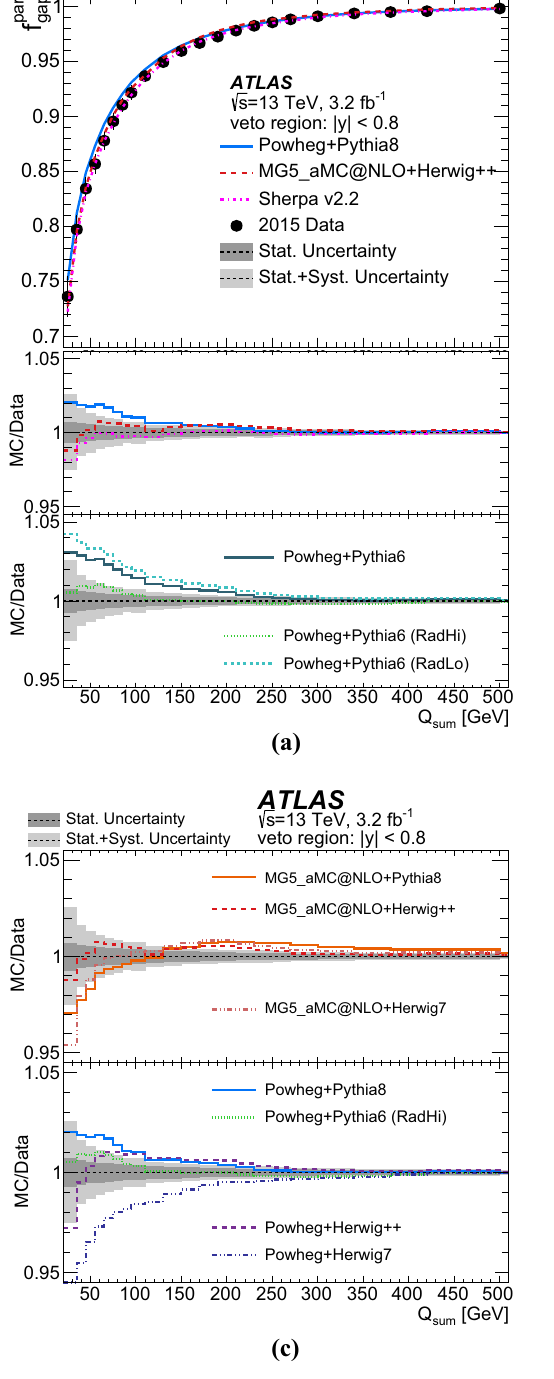
Fig. 11 The measured gap fraction f part gap ( Q sum ) as a function of Q sum in different rapidity veto regions, a | y | < 0 . 8 and b | y | < 2 . 1, followed by ratios of prediction to data of the measured gap fraction f part gap ( Q sum ) as a function of Q sum in the same two rapidity regions. The data in a and b are shown by the points with error bars indicating the total uncertainty, and compared to the predictions from various t ¯ t simulation